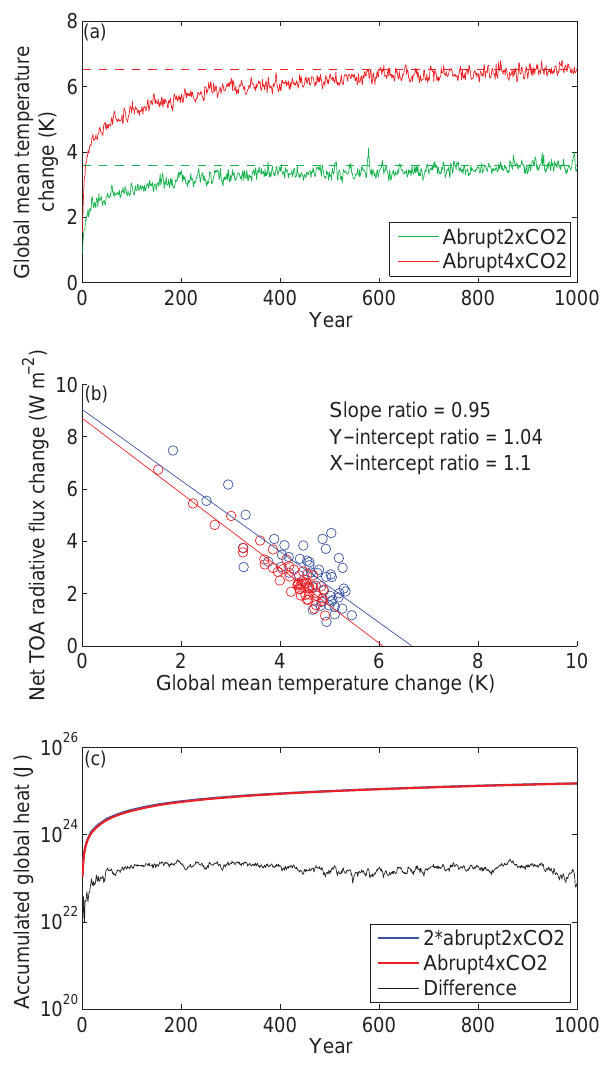
Figure 1. An illustration of nonlinearities in the climate system in- duced by step response simulations that, although not dominating climate system behavior, are potentially non-negligible. All sim- ulations were conducted with the fully coupled general circula- tion model HadCM3L (Jones, 2003). Top panel shows time se- ries of the change in global mean temperature in abrupt2xCO2 (green) and abrupt4xCO2 (red) simulations; approximate steady- state values are indicated by dashed lines. Middle panel shows an- nual mean temperature change and top-of-atmosphere (TOA) net radiative flux differences ( (cid:49)R ) from a preindustrial control (circles) for the first 50 years of twice the abrupt2xCO2 simulation (blue) and the abrupt4xCO2 simulation (red); lines are ordinary least-squares regression through the respective circles. Bottom panel shows ap- proximate global heat uptake for twice the abrupt2xCO2 simula- tion (blue) and the abrupt4xCO2 simulation (red) calculated as in Eq. (2); black line shows the difference between the blue and red